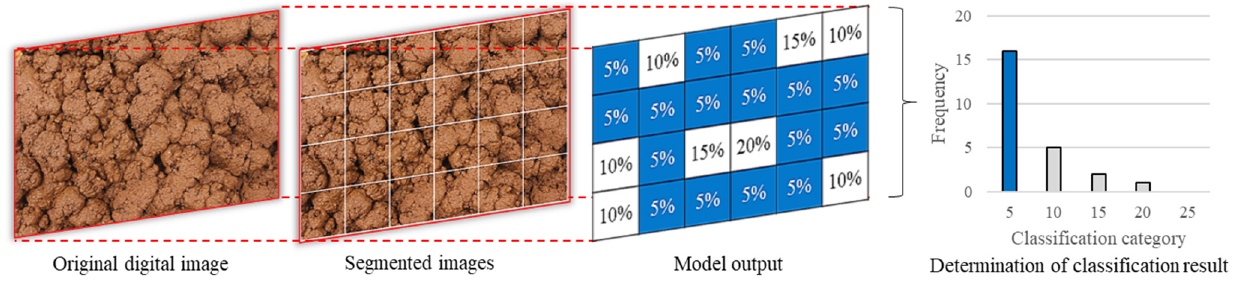
Figure 3. Classification result determination method by the convolutional neural network model. The quantitative prediction result of the original digital image by the CNNmodel is determined by Equation (1).